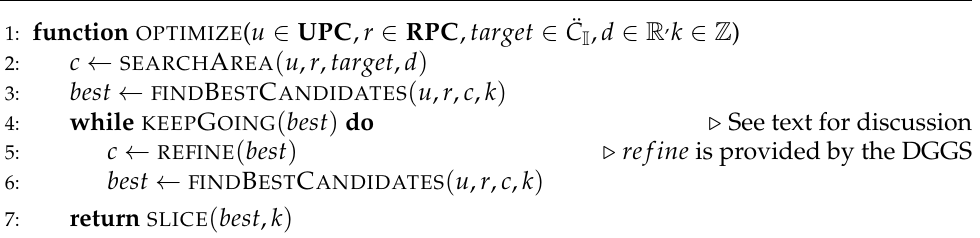
Algorithm 3 Perform a hierarchical search to find the k best